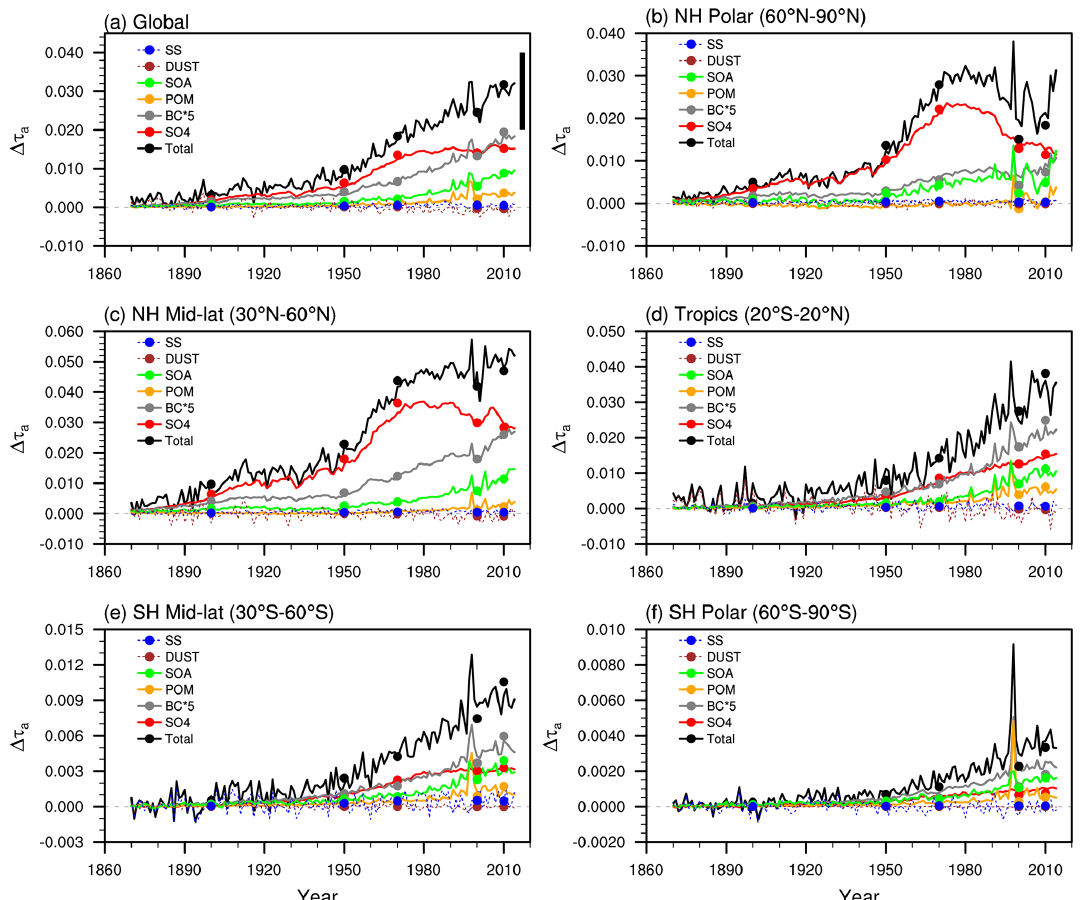
Figure 2. Similar to Fig 1, but for anthropogenic aerosol optical depth at 0.55µm (total and individual components). Solid lines indicate aerosol species that are directly influenced by anthropogenic aerosol emissions (SO 4 , BC, POM, SOA), and dotted lines indicate natural aerosols (DUST, SS, MOM) that are mainly driven by surface winds. Dots indicate results from the short nudged simulations. The black vertical bar in panel (a) shows the estimated range of total (cid:49)τ a by Bellouin et al. (2020). Note that the BC values are scaled by a factor 5 for easier comparison. See Sect. 3.1 for